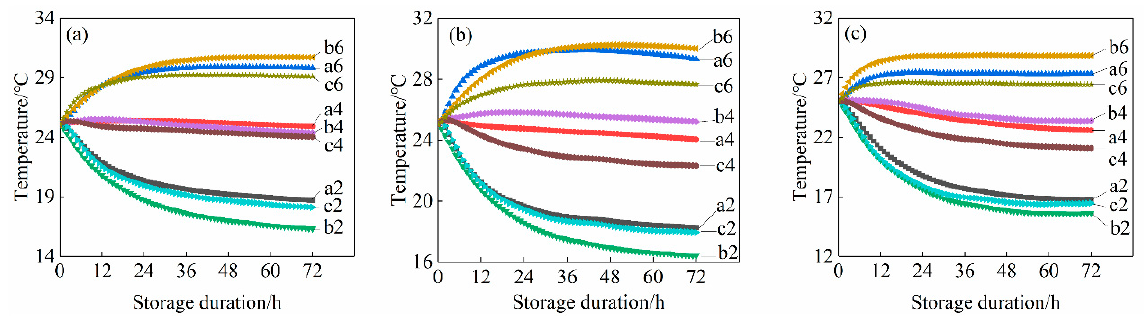
Table 1. Parameters of bulk grain pile and air.